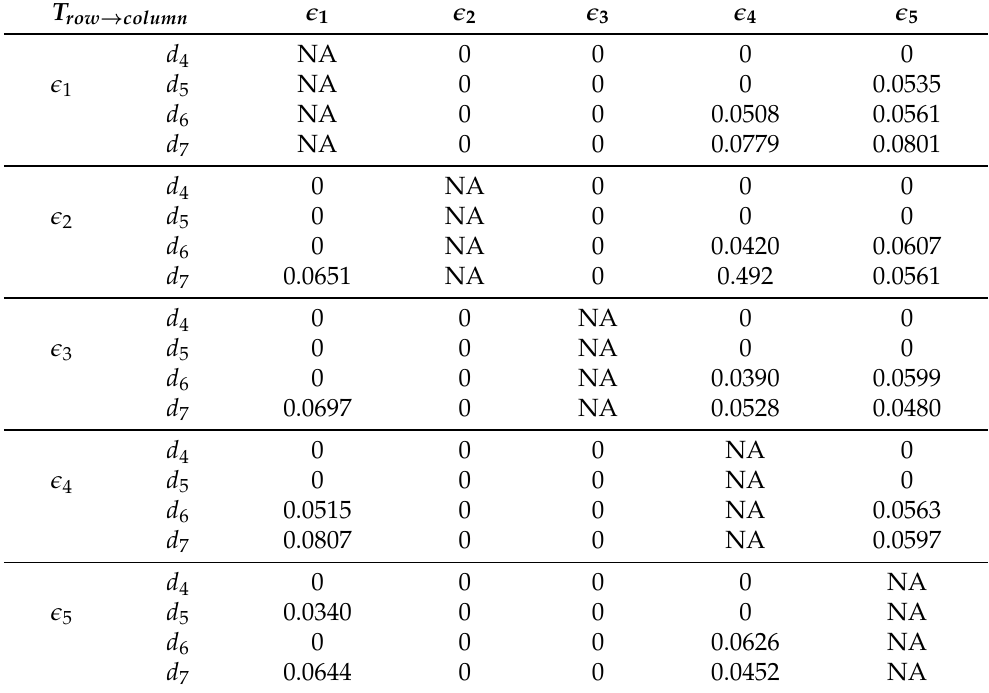
Table 2. Transfer Entropy coefficients for simulated data (Gaussian noise).